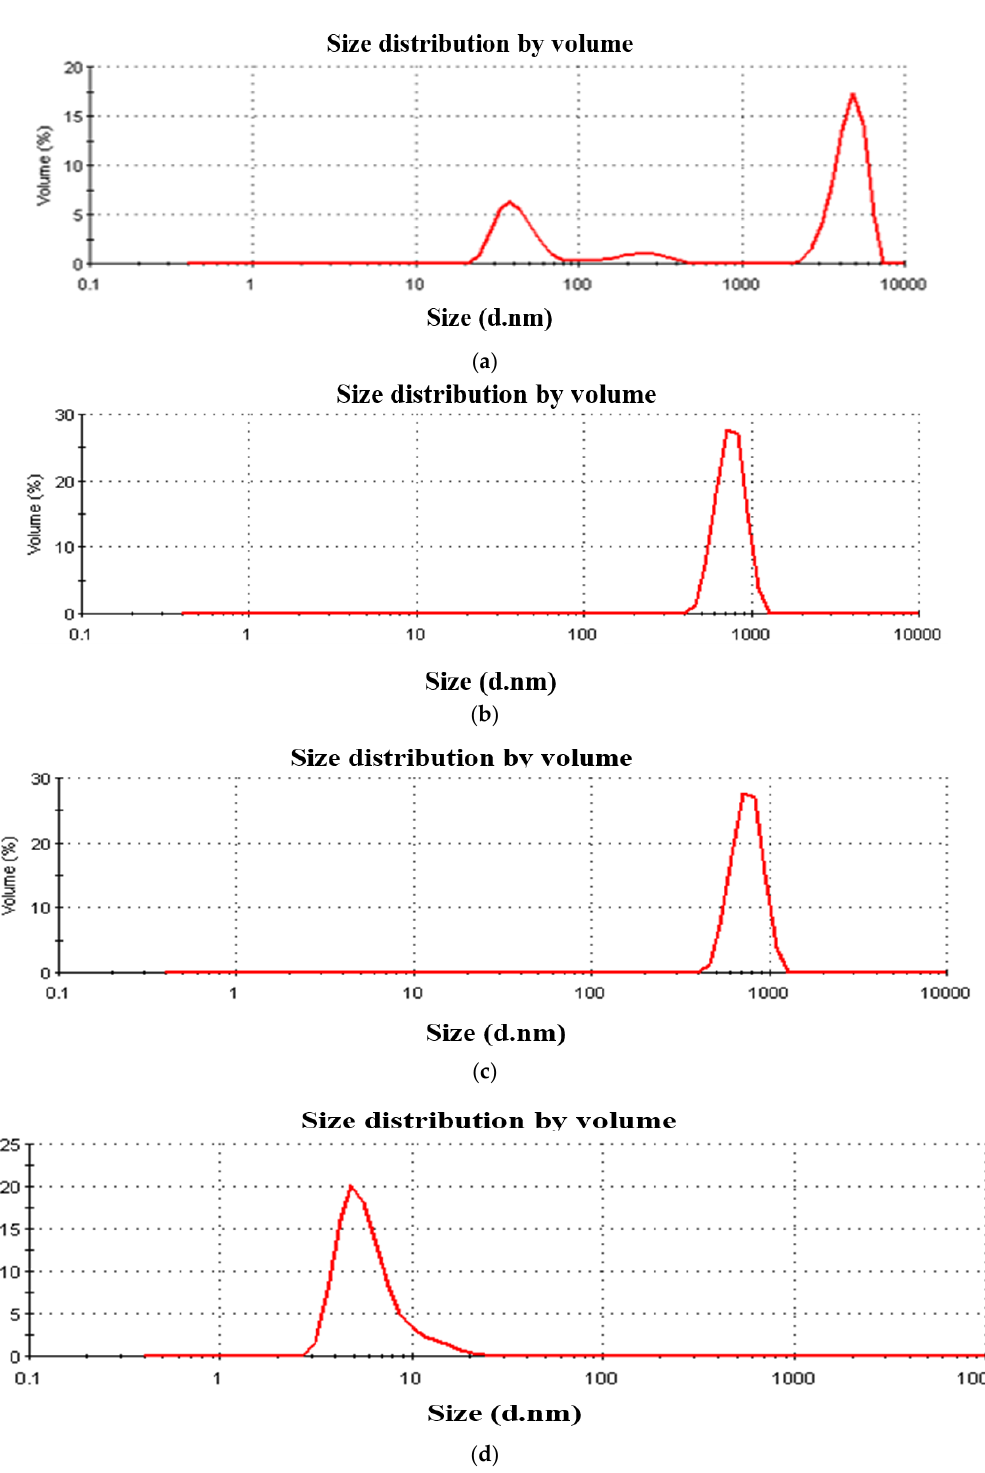
Figure 4. DLS particle-size distribution curves of chlorophyll diluted with acetone and treated for ultrasonic treatment times of; (a) 0 min, (b) 5 min, (c) 10 min, and (d) 15 min.